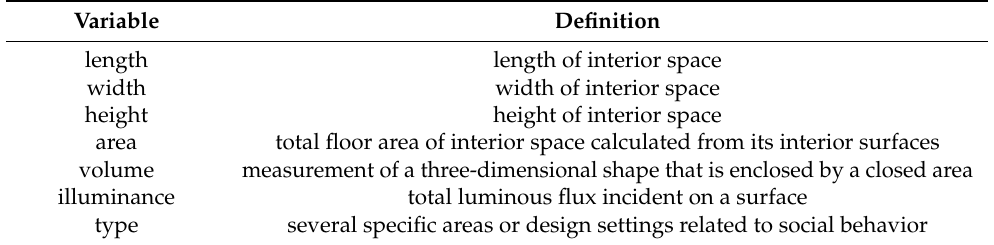
Table 1. Variables measured for each interior space where 360 ◦ panoramic images were captured.